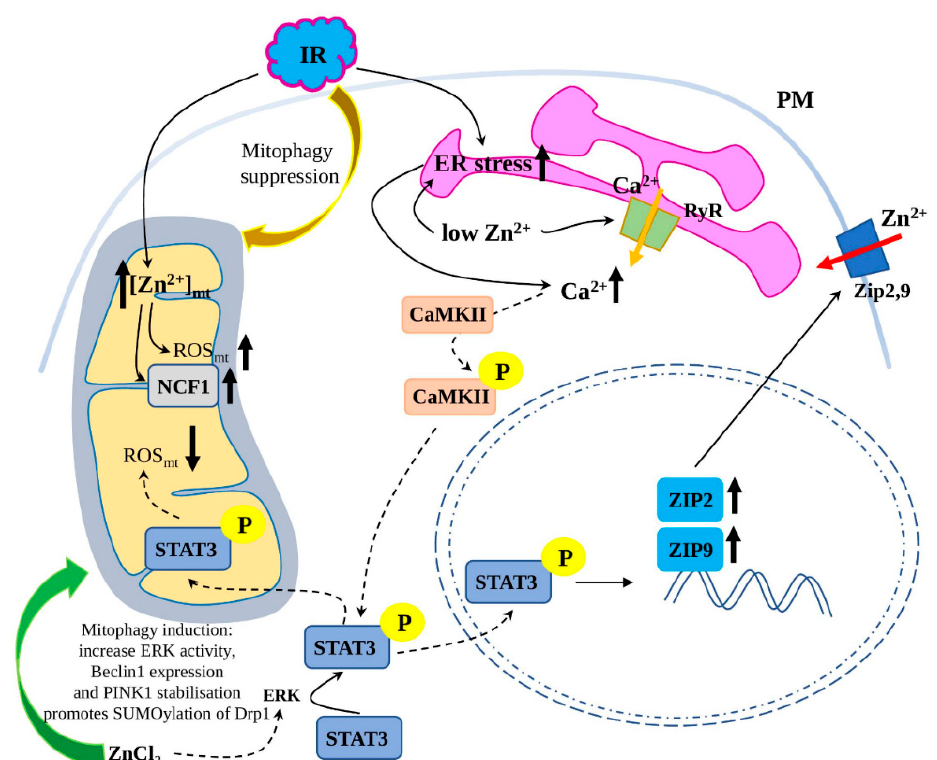
Figure 1. The role of Zn 2+ in ischemia/reperfusion injury (I/R). I/R was shown to suppress mitophagy, increase mitochondrial reactive oxygen species (ROS) production and induce endoplasmic reticulum (ER) stress. I/R leads to increased Zn 2+ accumulation in mitochondria, further increasing ROS production via (Neutrophil Cytosolic Factor 1) NCF1. I/R, similarly to Zn 2+ deficiency, induces ER stress, which leads to ryanodine receptor (RyR) channel activation and increase in intracellular Ca 2+ level and Ca 2+ -calmodulin-dependent protein kinase (CaMKII) phosphorylation, which subsequently acts on Signal Transducer and Activator of Transcription 3 (STAT3) to stimulate ZIP2 and 9 expression. Zn 2+ treatment provides cardioprotective effect by stabilising PTEN Induced Kinase 1 (PINK1) and dynamin 1 like (Drp1) proteins, increasing ATG6, Autophagy Related (Beclin1) expression and ERK activity, thus stimulating mitophagy. Additionally, ERK phosphorylates STAT3 in a Zn 2+ -dependent way. The direction of Zn 2+ transport is depicted with a red arrow, Ca 2+ —orange, increased/decreased levels of metabolites/gene expression—black; PM—plasma membrane.